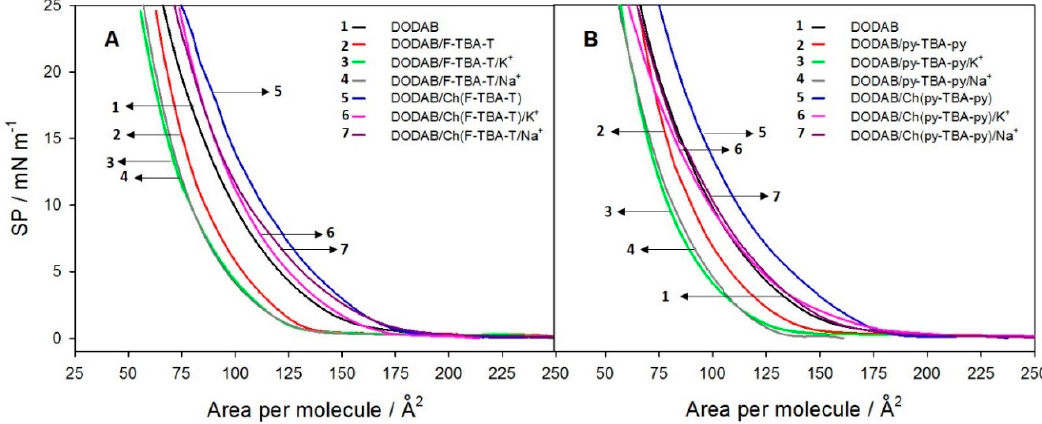
Figure 4. The π -A isotherms recorded for DODAB monolayer on a subphase containing 8.3 nM F-TBA-T and Ch(F-TBA-T) probes. ( A ), 8.3 nM py-TBA-py and Ch(py-TBA-py) probes. ( B ) in the absence and presence of potassium or sodium ions. Subphase contained 10 mM TA buffer, pH = 7.5.